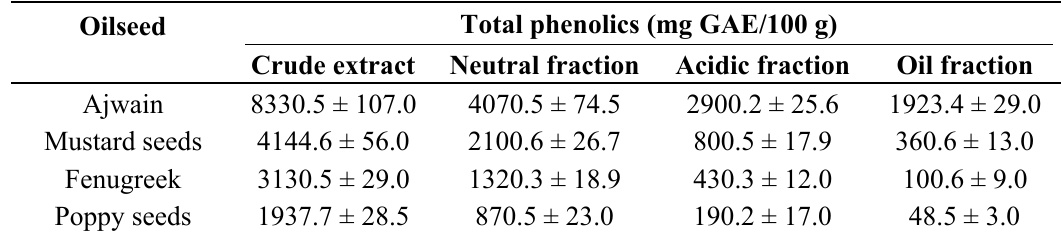
Table 2. Total phenolics of the crude extract, netural, acidic and oil